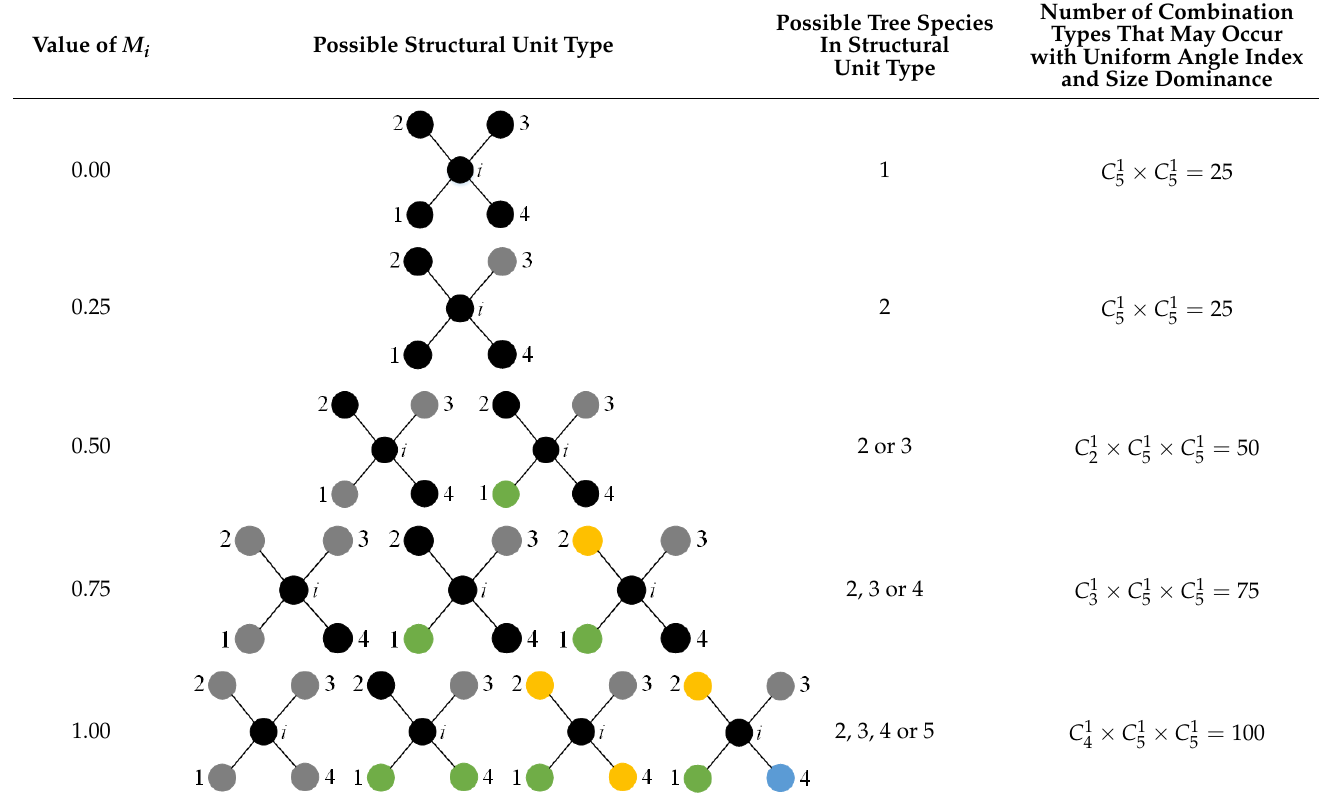
Table 2. Structural unit types with the same mingling value.